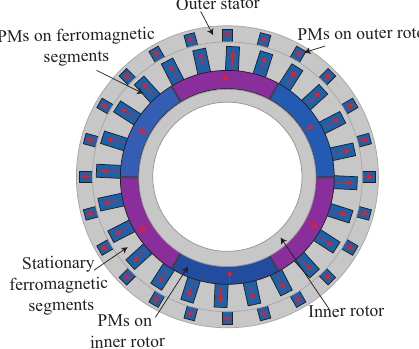
Figure 4. Triple PM excited Magnetic